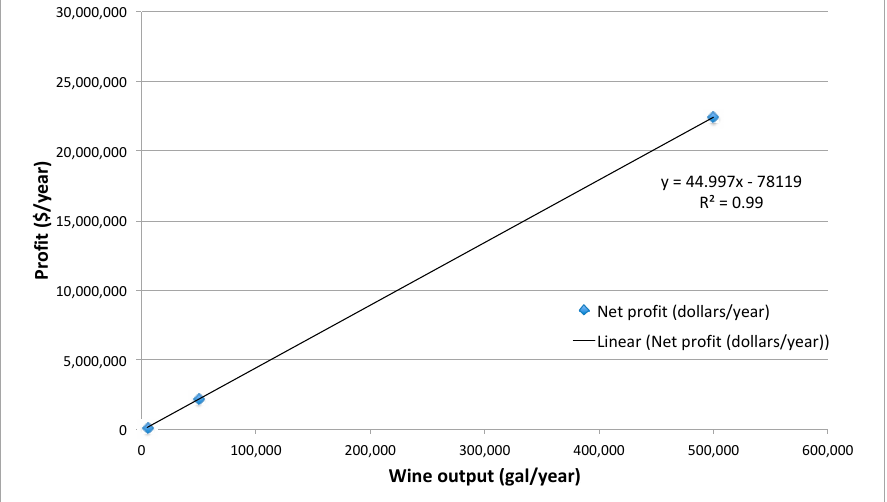
Figure 12. Annual net profit according to scale of operation (showing linear trendline).